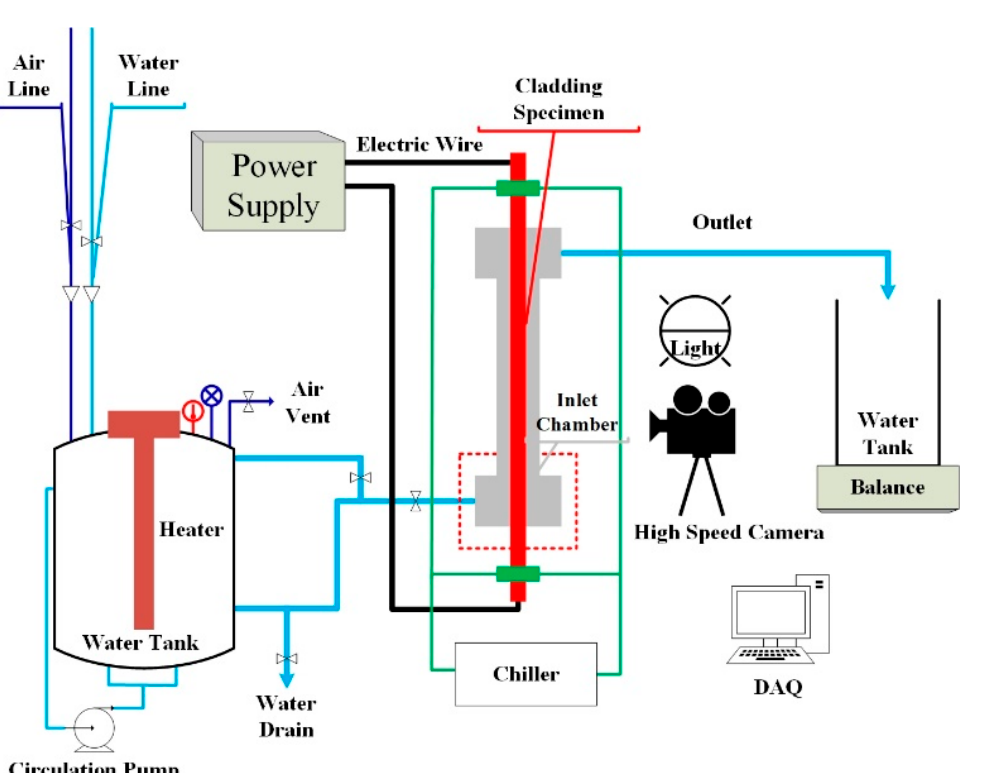
Figure 1. Schematic of experimental apparatus for reflood quenching.